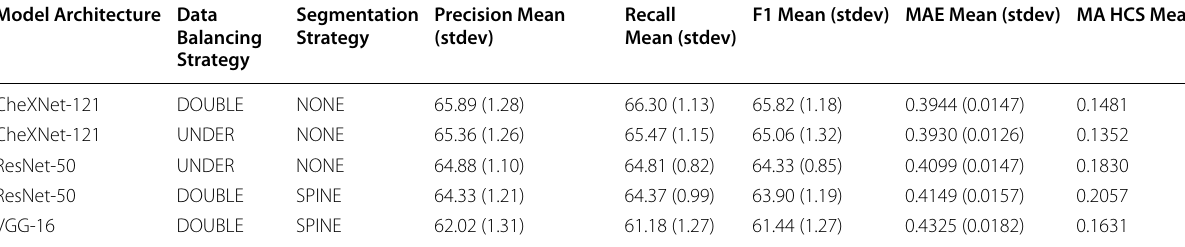
Table 4 Robustness comparison of final models across all five folds and choice of best model Model Architecture Data Balancing